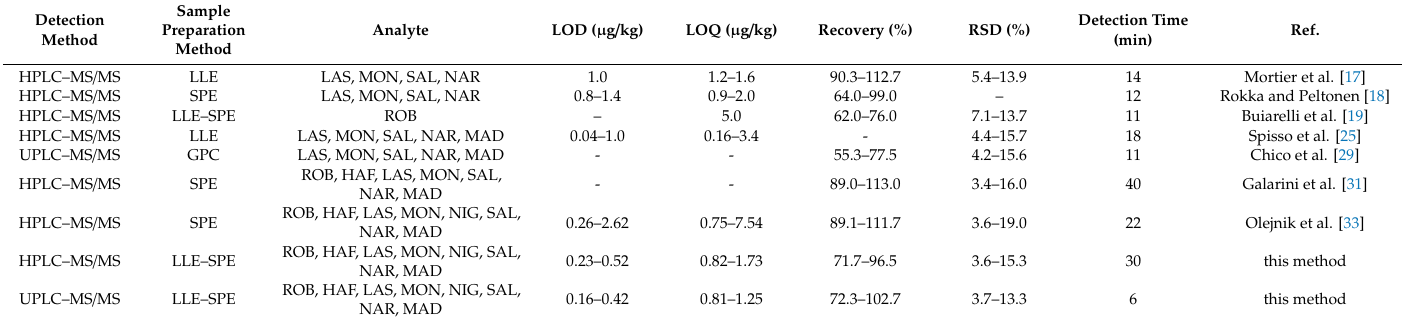
Table 6. Comparison of the presented two methods with other methods utilized for egg